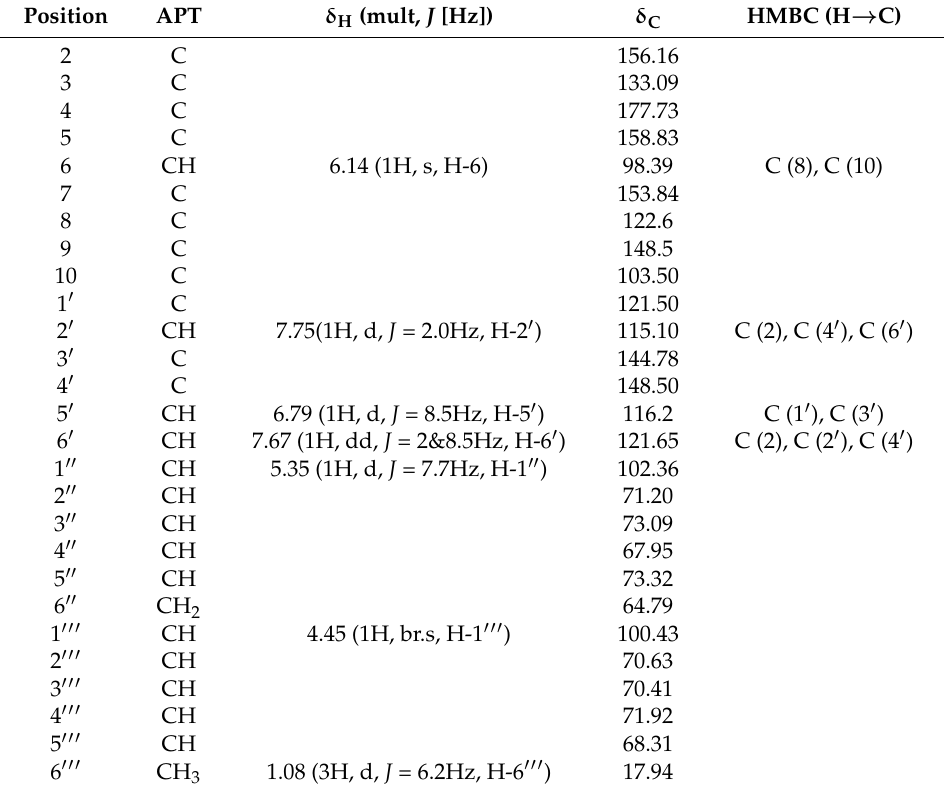
Table 1. 1 H and APT-NMR data and HMBC correlations for compound ( 11 ) ( gossypetin-3- O - β - D - robinobioside [rhamnosyl (1 → 6) galactoside]) recorded in DMSO- d 6 ; δ in ppm, J in